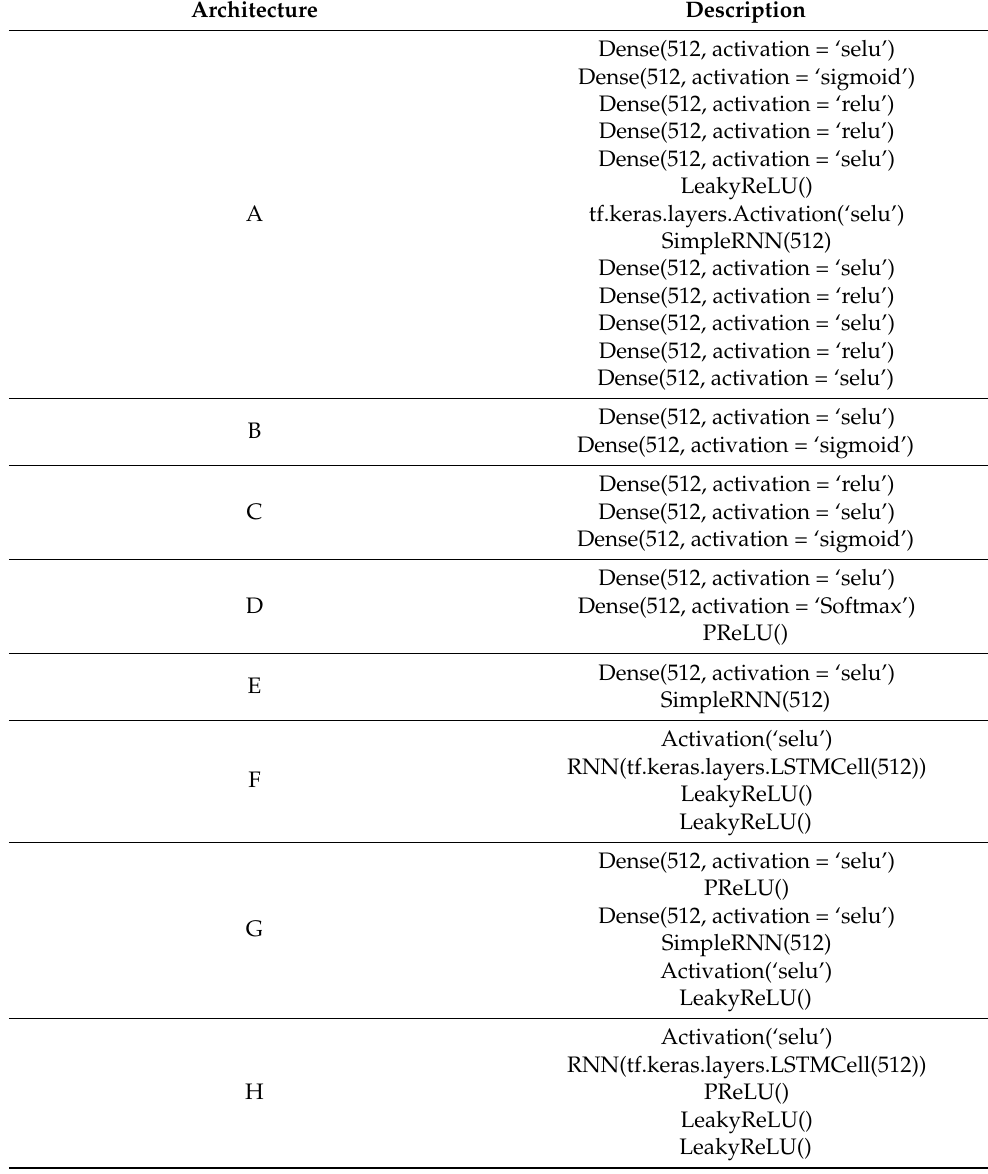
Table 1. Different structures used for network number (3): Extraction network.